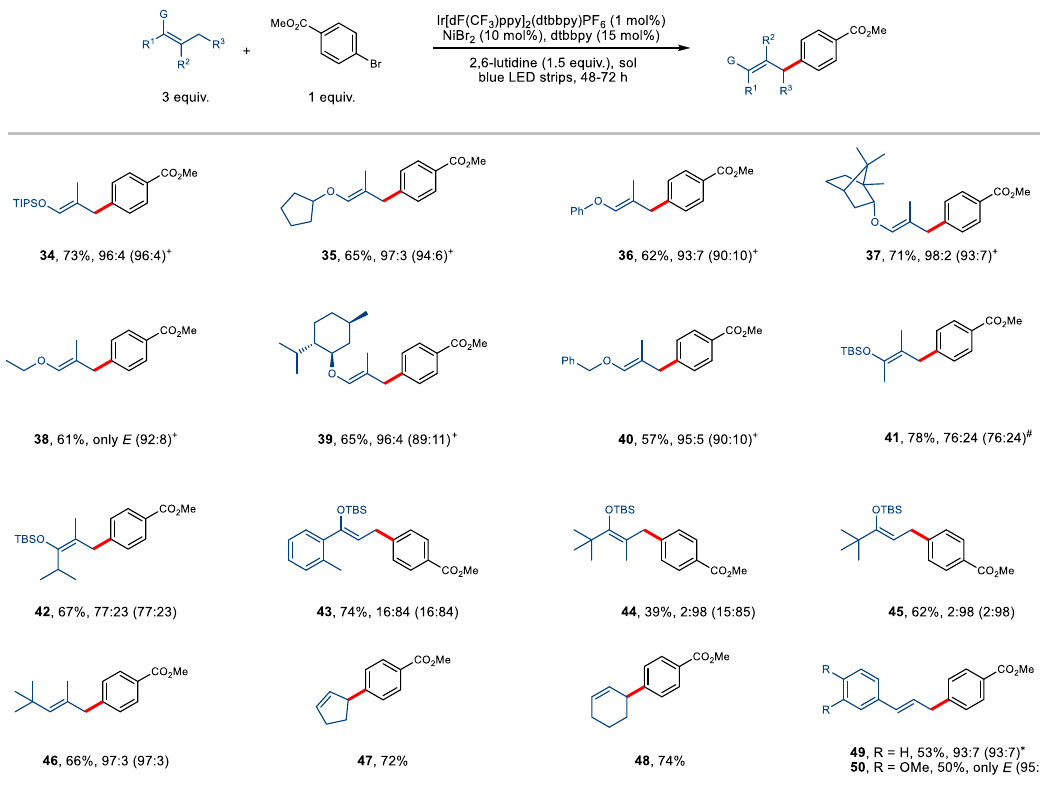
Fig. 3 | Scope of alkenes for the coupling with aryl bromide 2. Unless otherwise speci fi ed, the reactions were performed on a 0.2mmol scale under the following reaction conditions: alkene (3 equiv.), aryl bromide (1 equiv.), 2,6-lutidine (1.5 equiv.), PC-1 (1mol%), NiBr 2 (10mol%), dtbbpy (15mol%), benzene/THF 1:1 (2mL), rt, 48-72h, yields and E / Z after puri fi cation by chromatography (numbers in